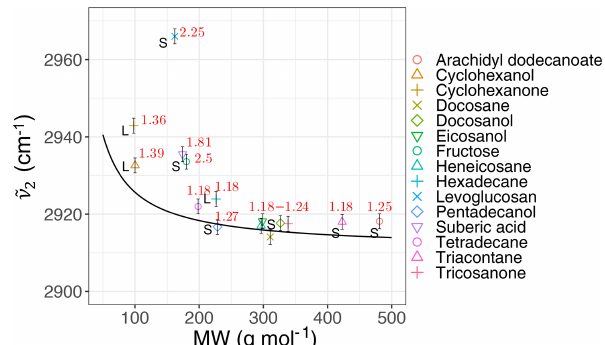
Figure 6. Scatter plot showing the variation of the second peak wavenumber ( ˜ ν 2 ) with molecular weight (MW) in the calibration set, affected by the OM / OC ratio and phase state. The black line shows the theoretical frequency with a spring constant equal to 10 3 Nm − 1 for all C − H bonds. The OM / OC ratio and phase state are shown for the samples. The error bars show uncertainty in cal- culated peak frequency due to FT-IR scan